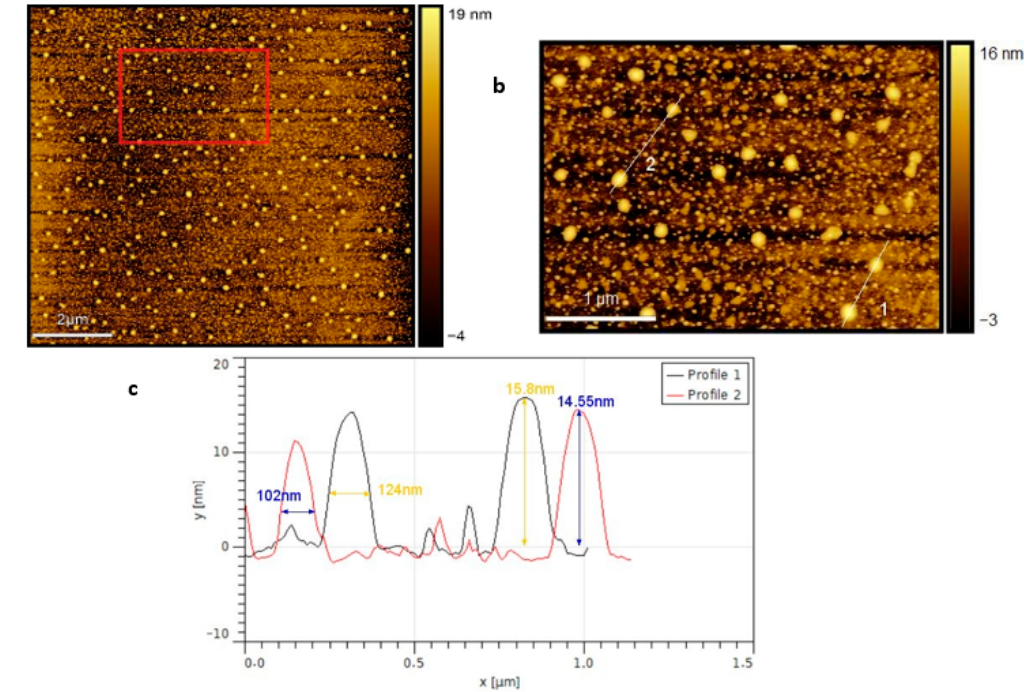
Figure 3. AFM images of 5 ML MoS 2 : ( a ) 10 × 10 µm scan. ( b ) Magnified region from red box in ( a ). ( c ) Height profiles of magnified regions along lines 1 and 2 from ( b ).